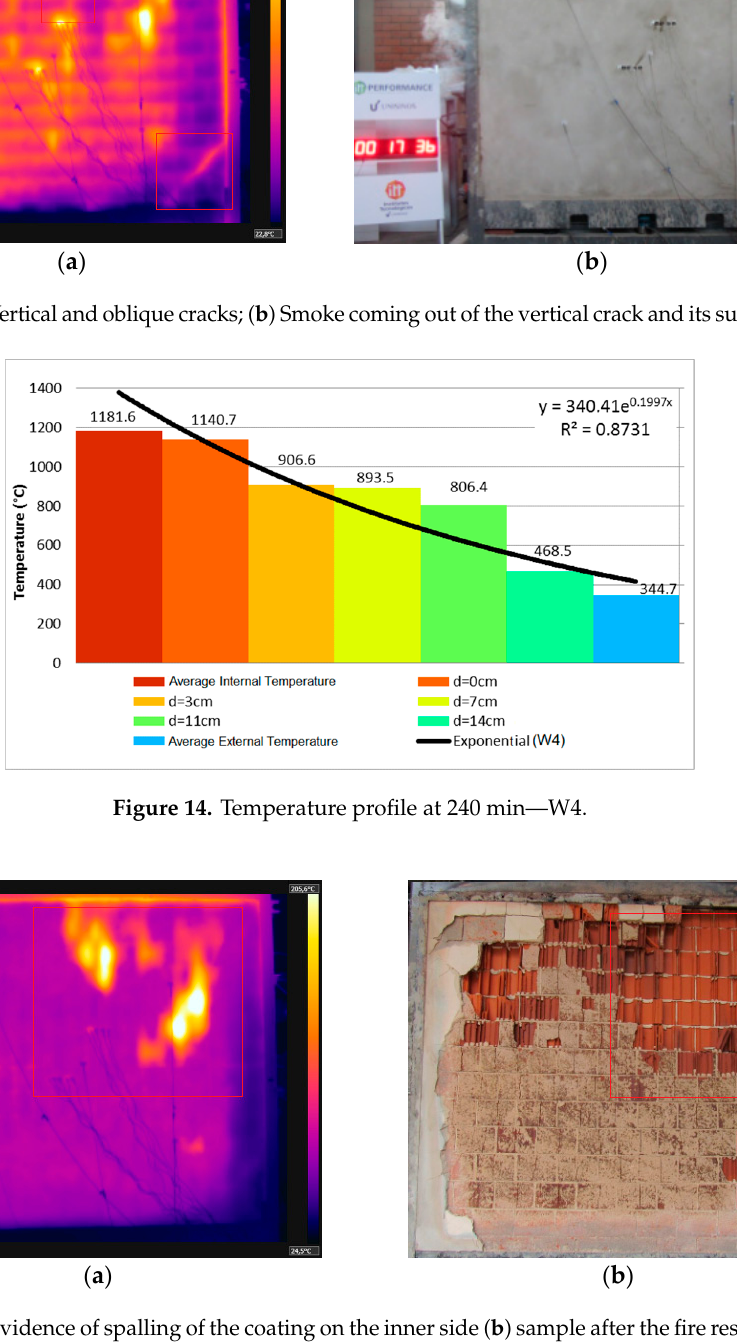
Figure 15. ( a ) Evidence of spalling of the coating on the inner side ( b ) sample after the fire resistance